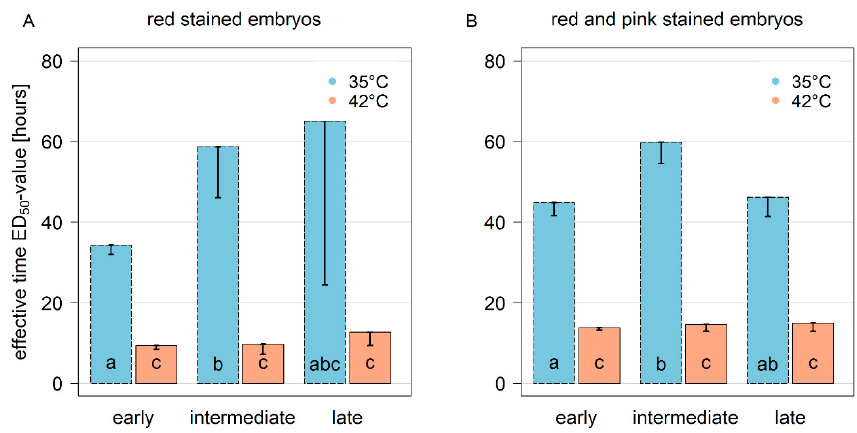
Figure 3 . ED 50 values, the time until half of former viable seeds are negatively affected, of Heracleum mantegazzianum seeds in hours of exposure time in water baths at 35 and 42 °C, for harvest times: 2 weeks (early), 5 weeks (intermediate), and 8 weeks (late) after flowering. ( A ) Viable (red) embryos; ( B ) Viable (red) and damaged (pink) embryos. Mean and lower part of the symmetrical standard error. Letters show significant di ff erences between treatments ( p < 0.05, non-parametric posthoc